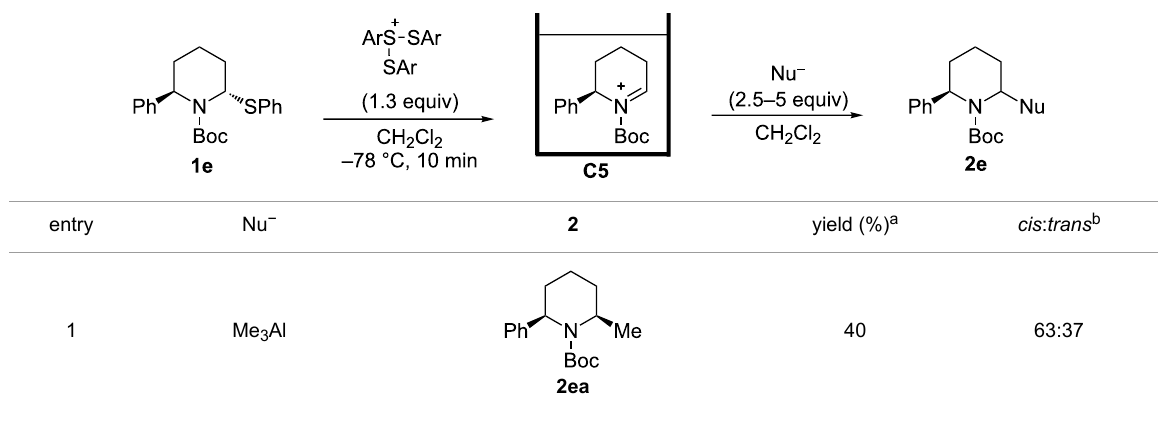
Table 5: Reaction of N- acyliminium ion C5 with several